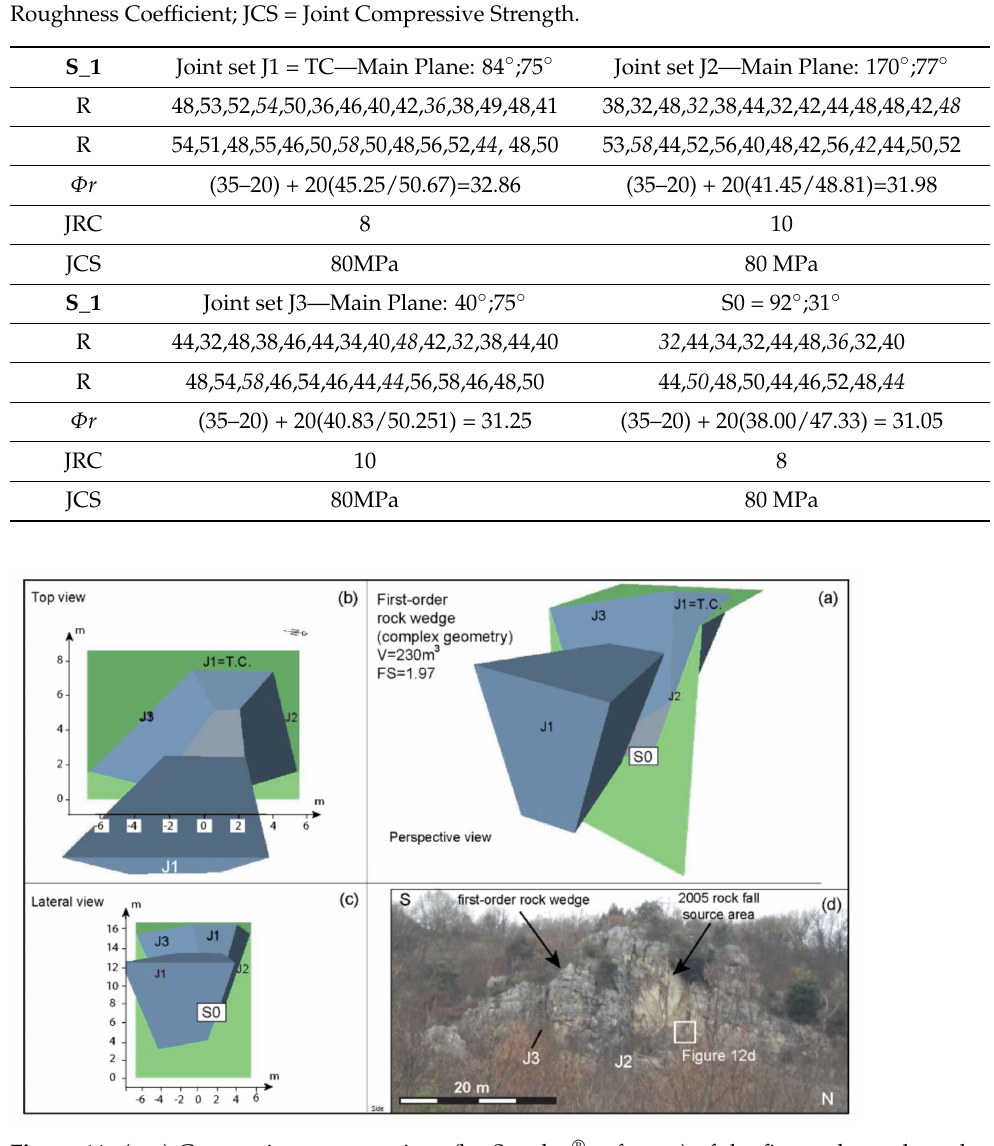
Figure 11. ( a – c ) Geometric reconstructions (by Swedge ® software) of the first-order rock wedge detached during the 2005 rockfall event; ( d ) rock pillar with similar geometry and size on the Es1